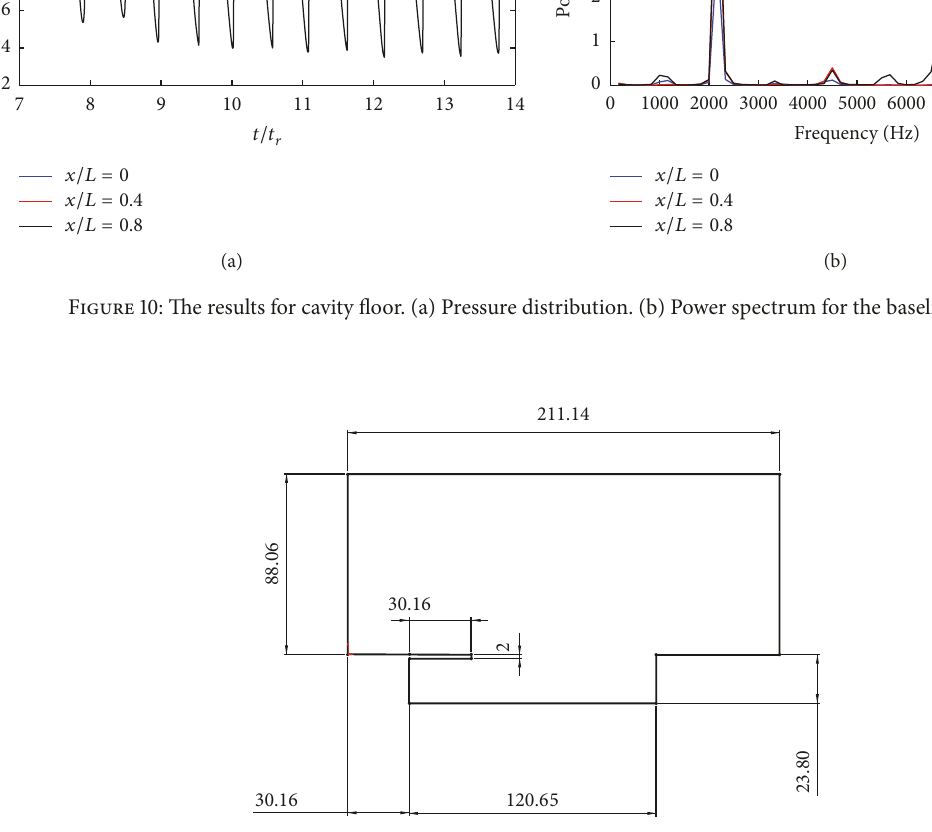
Figure 11: Cover plate